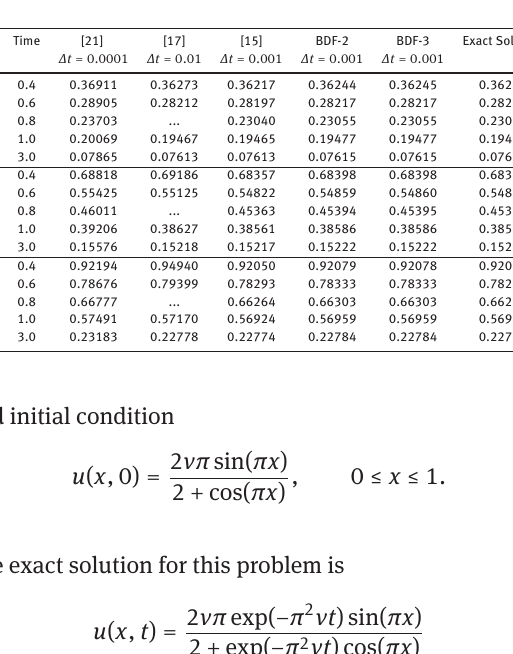
Table 9: Comparison with different numerical methods and exact solution of example 2 for ν = 0.01